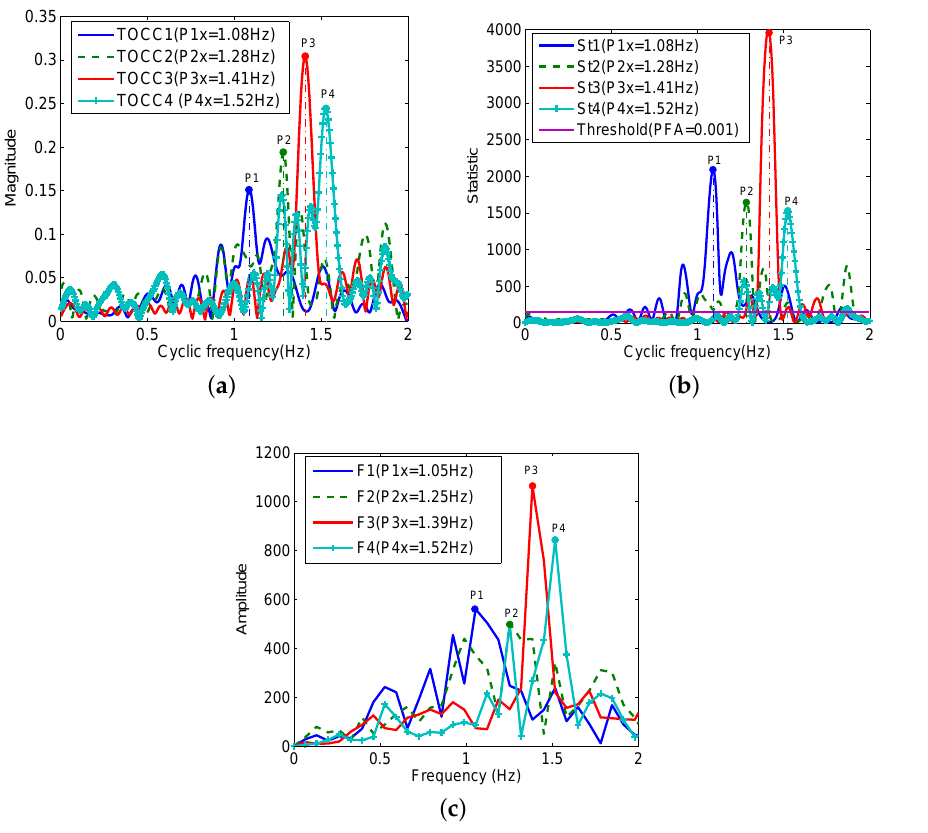
Figure 9. Estimated results of the heartbeat in the state of holding breath. ( a ) TOCC estimators of Subject1, Subject2, Subject3 and Subject3 plus motion; ( b ) Test statistic; ( c ) FFT spectrum corresponding to the Subject1, Subject2, Subject3 and Subject3 plus